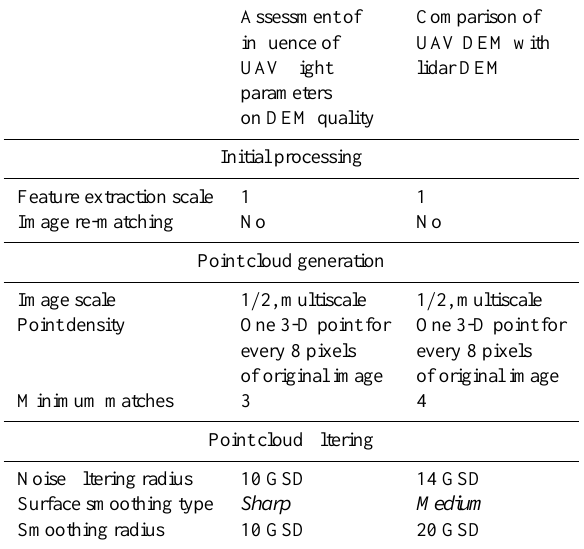
Table 3. Pix4D settings that were used to generate the UAV